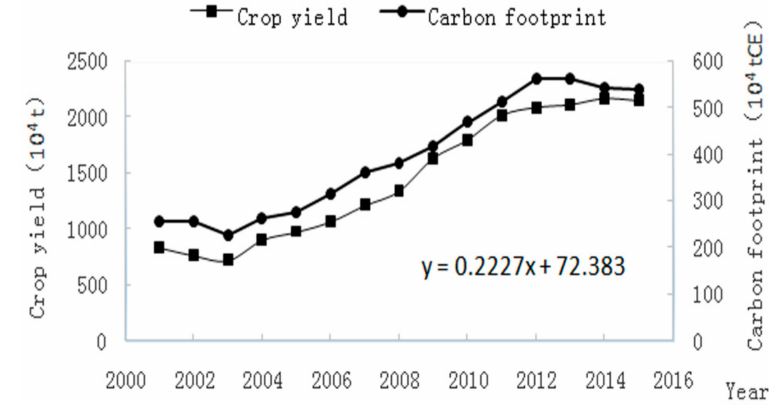
Figure 3. Relationship between carbon footprint and crop yield in the HLRA